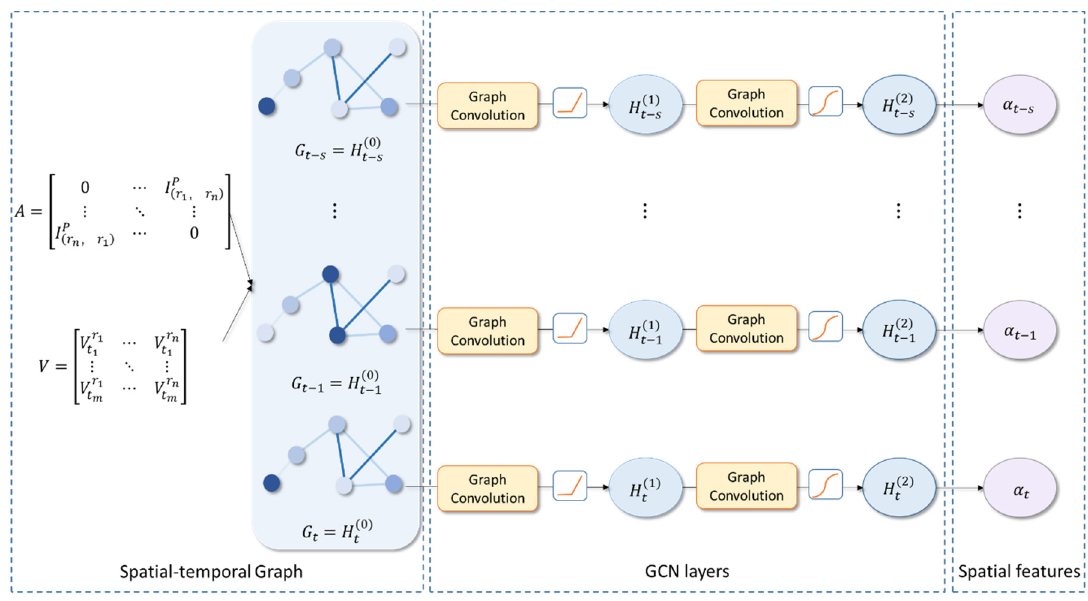
Figure 6. Graph convolutional network (GCN) learning process. Two GCN layers have been used in GGCN-GRU.